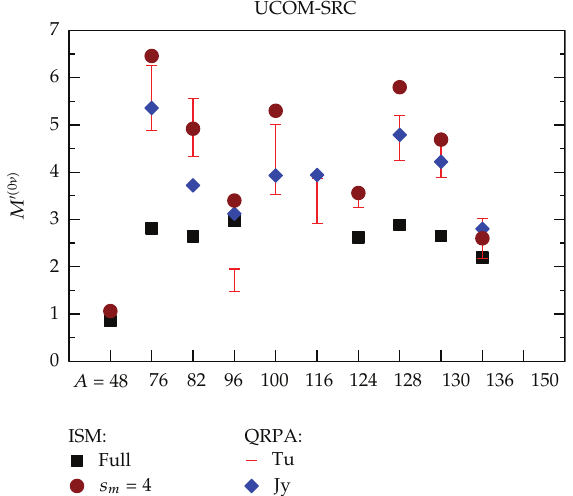
Figure 6: The QRPA results of Figure 2 compared with the ISM ones truncated at seniority s (cid:7)